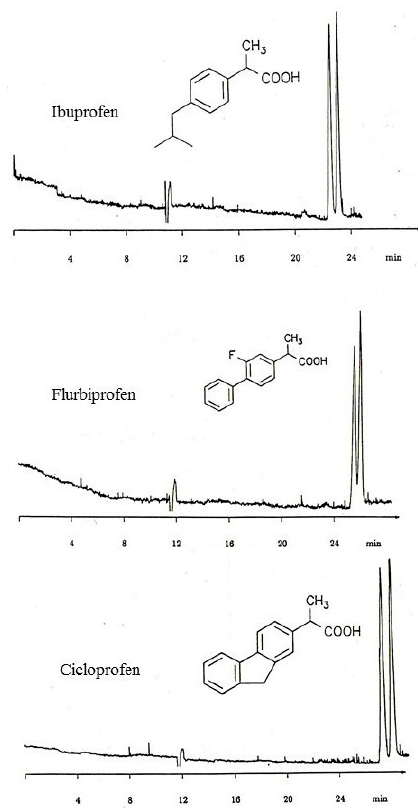
Figure 4 . Enantioseparation of profens by electrochromatography on Chirasil- β -Dex coated and immobilized (d f = 0.20 μ m) on an 80 cm (effective) × 50 μ m I.D. fused-silica capillary at 20 °C and 30 kV. Buffer: 20 mM Tris/HCl at pH 7. Reproduced from S. Mayer, Doctoral Thesis, University of Tübingen, Tübingen, Germany, 1993.